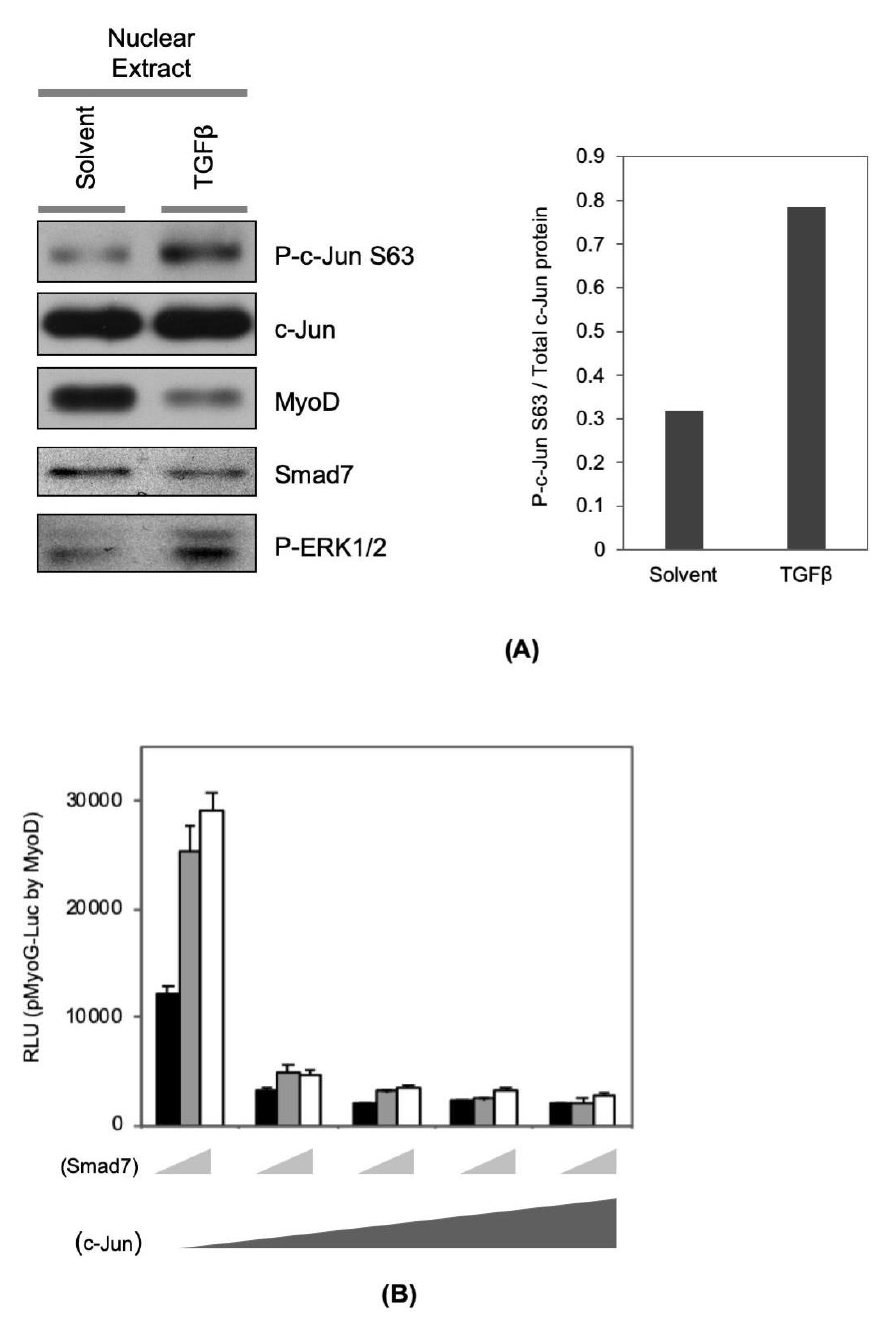
Figure 4. TGF β signaling modulates MyoD co-activator and co-repressor proteins. ( A ) C2C12 cells were seeded onto cell culture plates at equal density and maintained in TGF β (1 ng / mL) or solvent in DM for 16 h. Nuclear protein was extracted by using NE-PER ® . The amount of indicated nuclear protein was visualized with standard Western blotting technique (left panel). The band intensity of P-c-Jun and total c-Jun were measured using ImageJ, and the ratio of the P-c-Jun to the c-Jun band intensity was graphed in the presence and absence of TGF β (right panel). ( B ) C2C12 cells were transfected with myogenin promoter-luciferase reporter gene construct (pMyoG-Luc) with MyoD expression vector, and increasing amounts of c-Jun expression vector (0, 0.1, 0.4, 0.8, 1.6 µ g) and combinations with Smad7 expression vector (0, 0.5, and 1 µ g). In addition, to monitor transfection e ffi ciency, pCMV- β -gal construct was included in each condition. The transfected cells were maintained for 16 h in DM. Total protein samples were harvested with a luciferase lysis bu ff er. Luciferase activity in each condition was measured independently and normalized according to β- Galactosidase activity ( n = 3, +/- SD).